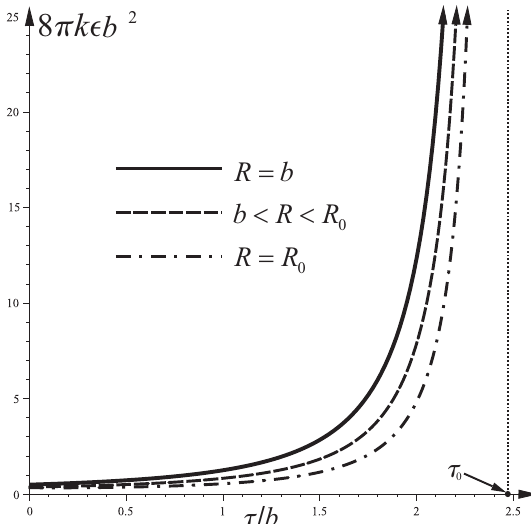
Figure 3. The figure shows the graphs of the energy density 8 π k ε b 2 depending on τ / b for different values of R : R = b , R = 1.1 b and R = R 0 , R 0 = 1.2 b . As τ → τ 0 the energy tends to infinity, the vertical asymptote is shown by dash-dot on the right in the